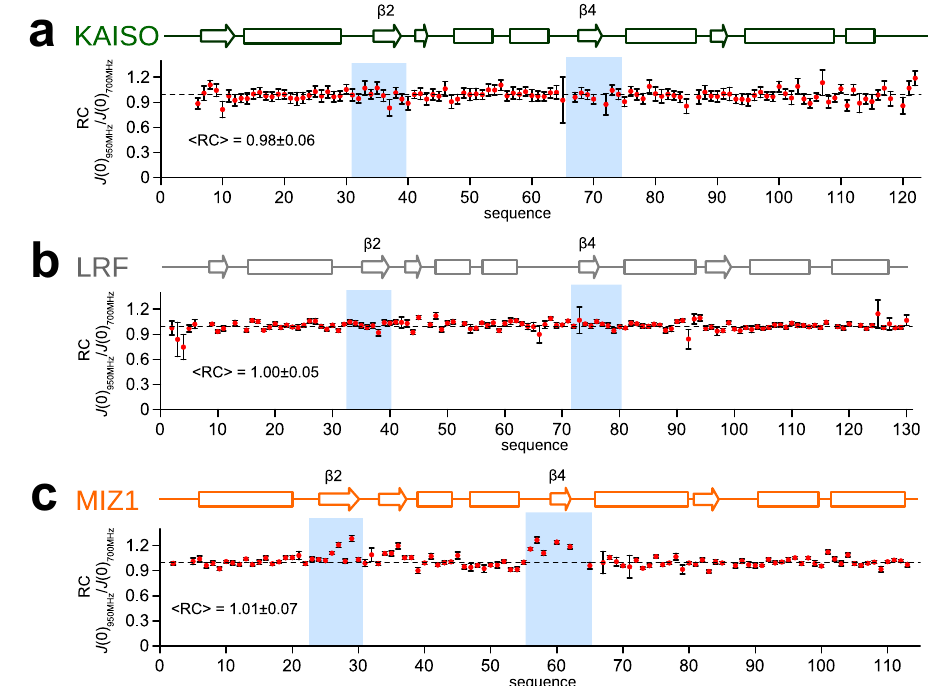
Fig.3|BTBdomainsofKAISO,MIZ1,andLRFdisplaydistinctdynamicpro fi les. The spectral density analysis plots derived from a comprehensive set of 15 N spin relaxationobservables,attwomagnetic fi eldstrengths,forKAISO BTB ( a ),LRF BTB ( b ), and MIZ1 BTB ( c ). The RC i ratio errors are propagated from the spin relaxation